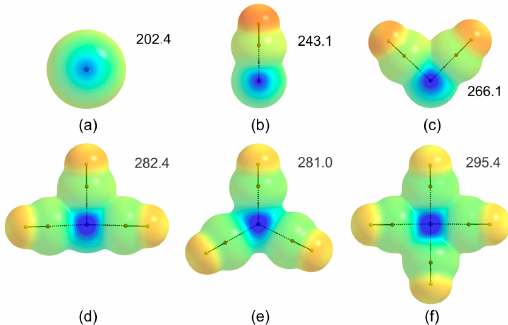
Figure 5. Molecular electrostatic potential on the 0.001 au electron density isosurface of the (BrF) n supermolecules. The maximum ( V S,max ) electrostatic potential (in kJ mol − 1 ) on the central Br atom is indicated. The equivalent values for (ClF) n set of complexes are: ( a ) 167.3; ( b ) 200.7; ( c ) 221.1; ( d ) 237.1; ( e ) 237.1; ( f ) 251.8. The values of the MEP vary between − 105 kJ mol − 1 (red) and +295 kJ mol − 1 (blue).